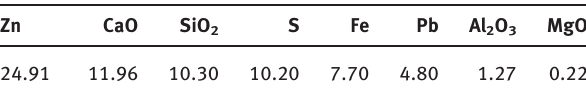
Table 1: Main chemical composition of oxide – sulphide zinc ore (mass fraction, wt%).